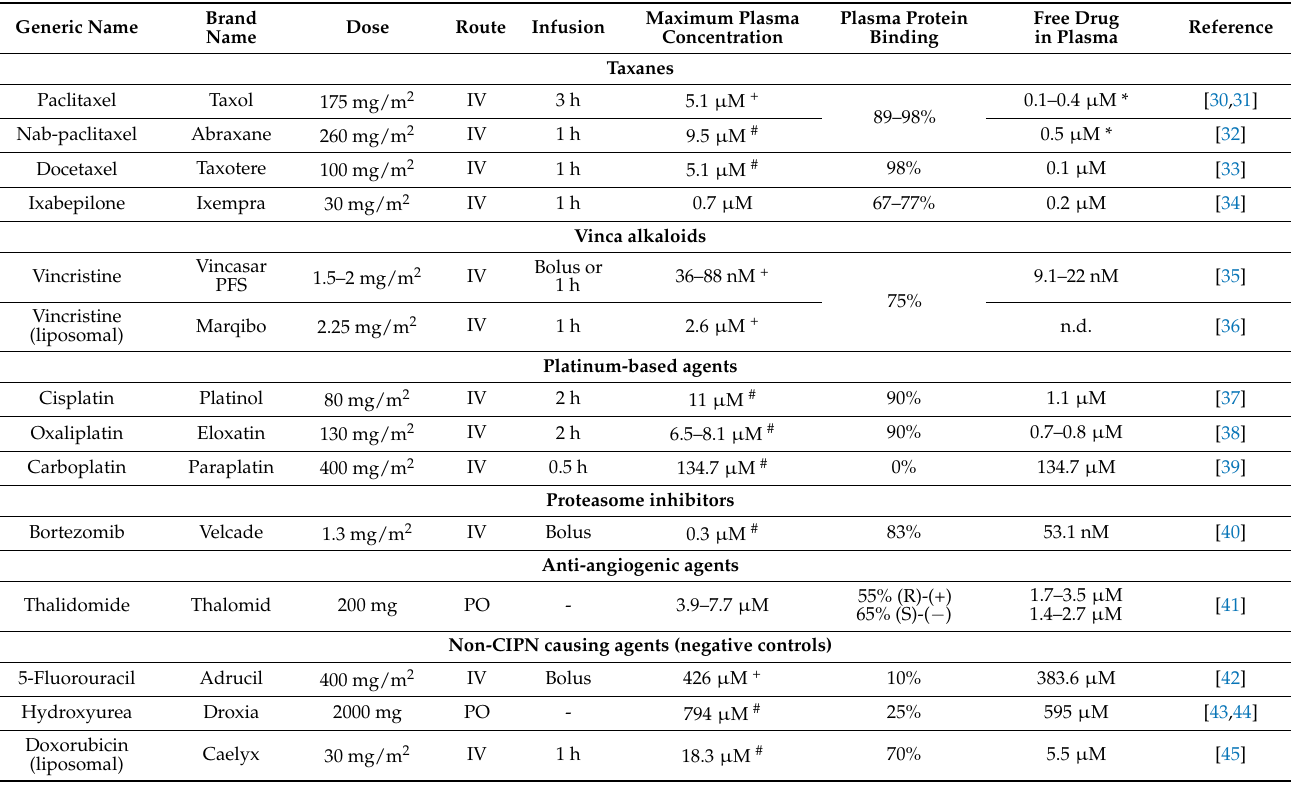
Table 2. Overview of key human pharmacokinetic parameters for chemotherapeutics that cause CIPN and relevant negative